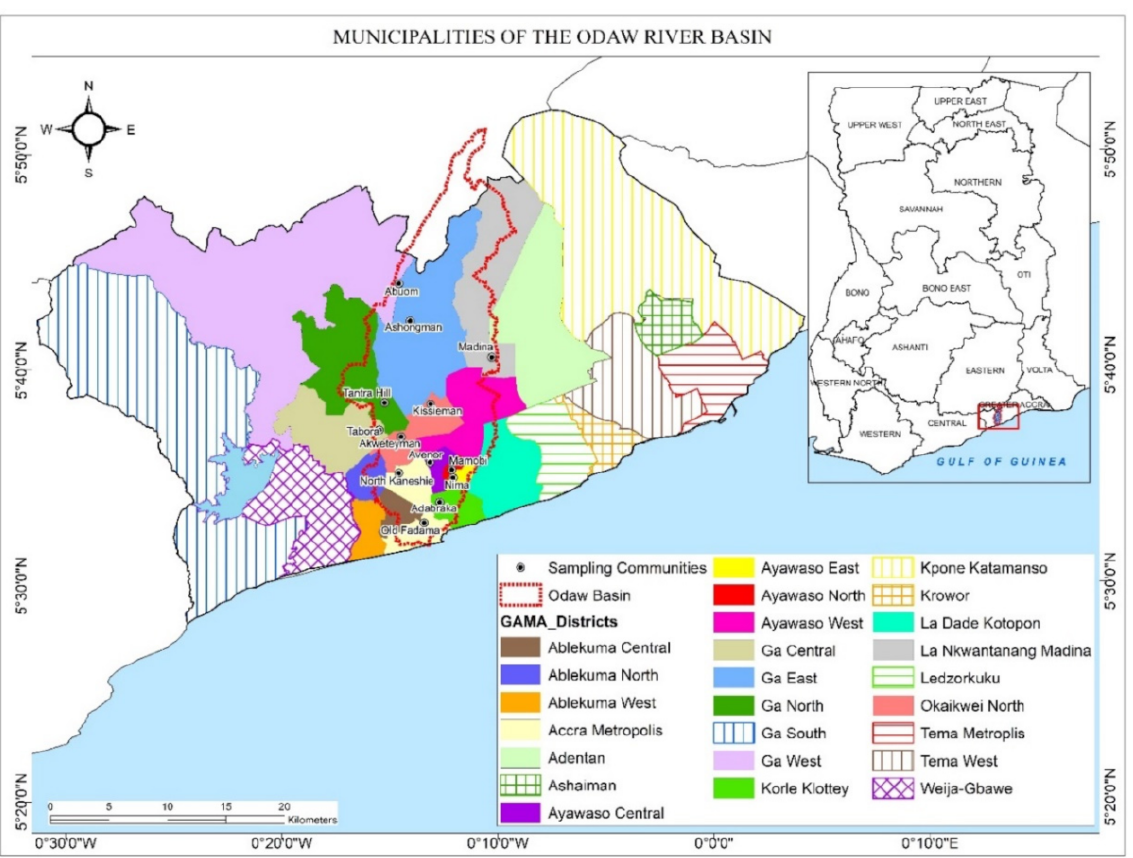
Figure 3. The communities and municipalities (solid shadings) of study within the Odaw River Basin of Ghana. Source: The